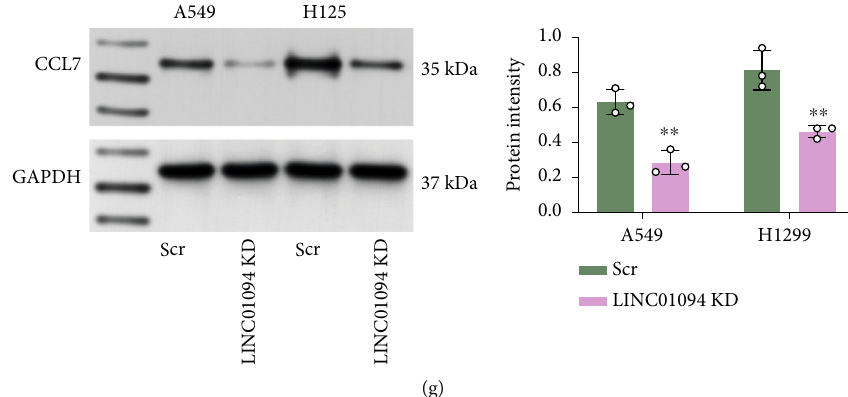
Figure 7: LINC01094 binds to SPI1 to regulate CCL7 expression. (a) Correlation of LINC01094 with CCL7 predicted in the TCGA-LUAD database; (b) binding relationship between LINC01094 and SPI1 validated in TCGA-LUAD database; binding between LINC01094 and SPI1 examined by RIP (c) and biotin-LINC01094-based RNA pull down (d) assays; (e) subcellular localization of LINC01094 and SPI1 in H125 and A549 cells examined by FISH assay; mRNA (f) and protein (g) levels of CCL7 in A549 and H125 cells after LINC01094 knockdown examined by qPCR and WB analyses. Repetition = 3 . Data are presented as the mean ± SD . ∗∗ p < 0 : 01